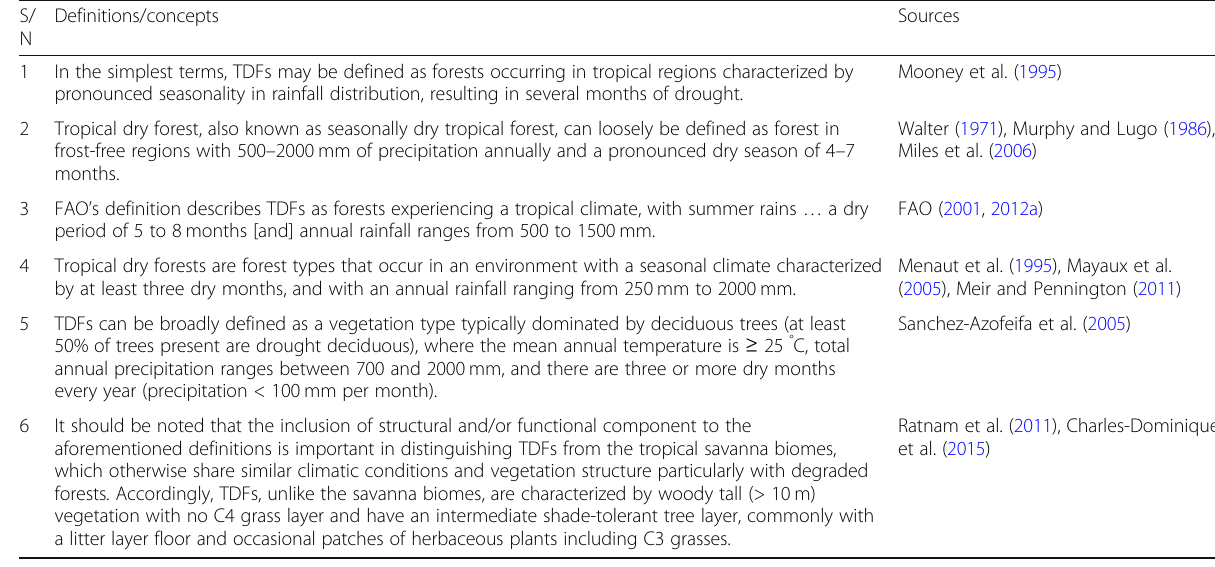
Table 1 Some definitions/concepts of tropical dry forests provided by different authors S/ N